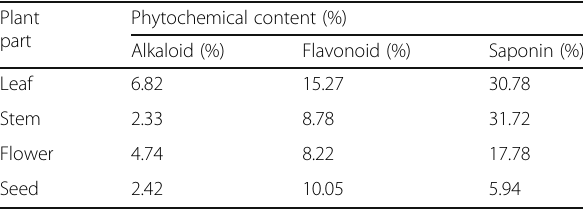
Table 1 Phytochemical content (%) of different parts of the plant of Cassia sophera